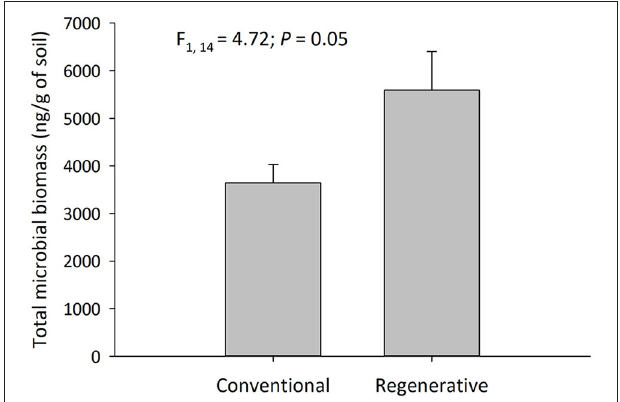
FIGURE 4 | Total microbial biomass collected from the soil in regenerative and conventional almond orchards (mean ± SEM, N = 16 orchards, α = 0.05). This sampling occurred during the fruiting period.